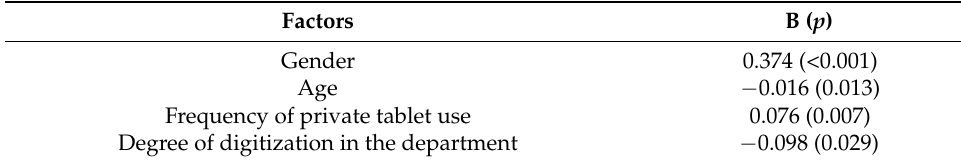
Table 3. Significant factors in the regression analysis for technical